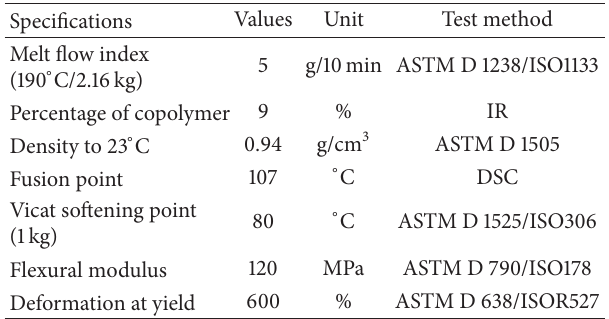
Table 2: Characteristics of compatibilizer E-EA-MAH.